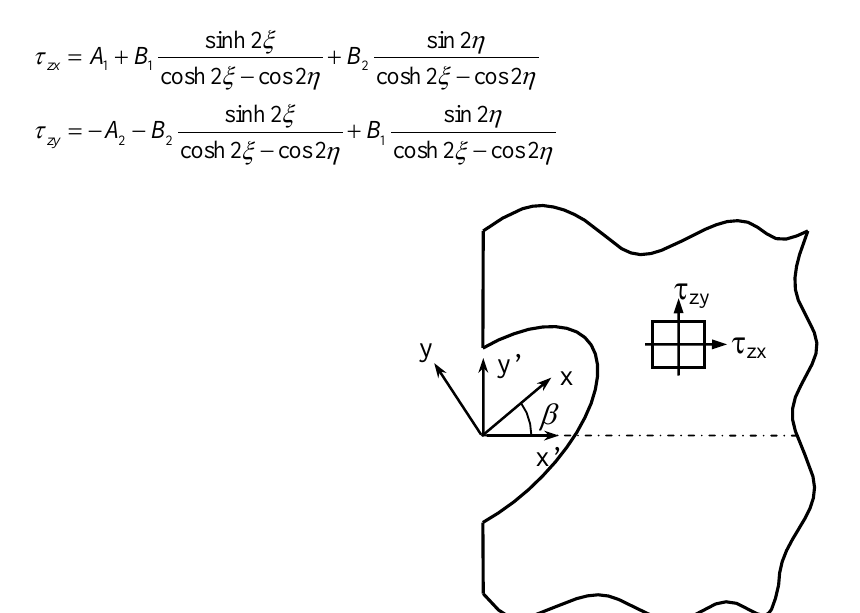
Figura A1: Intaglio ellettico inclinato di un angolo β rispetto alla direzione x’